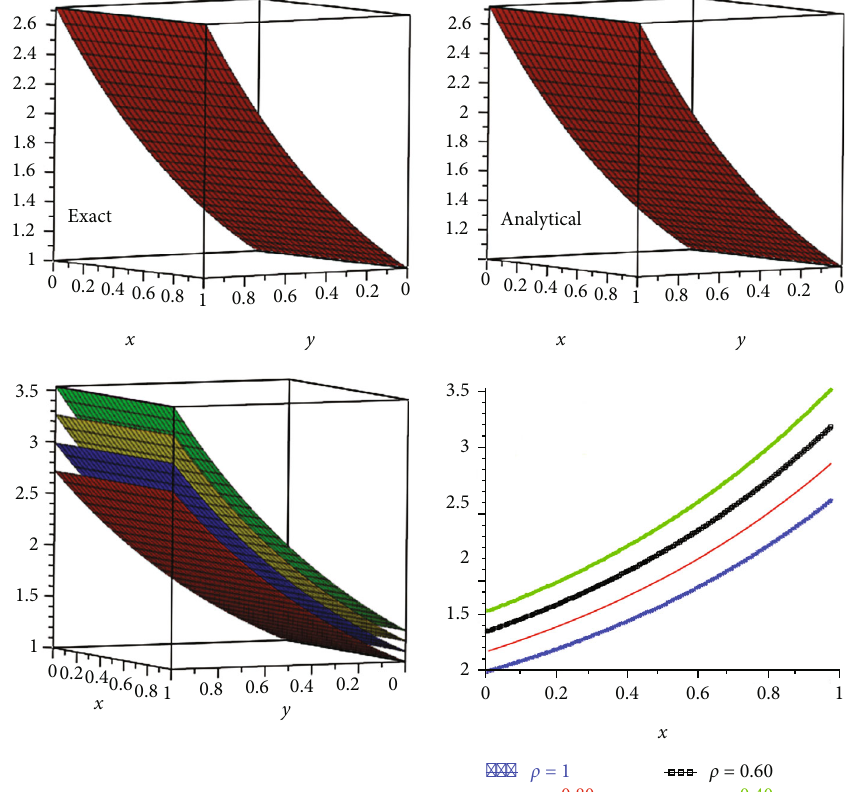
Figure 1: The graphical layout for problem